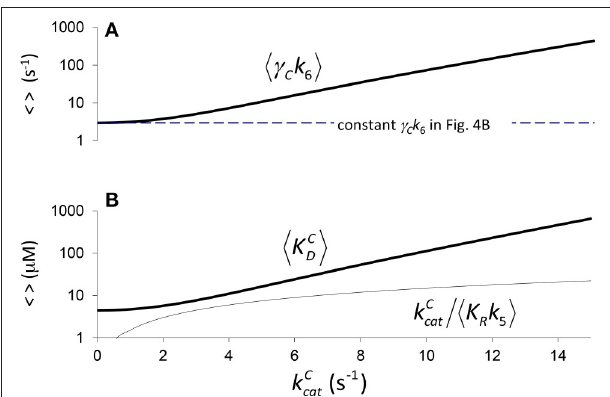
is estimated by (Equations 4, 7, cat